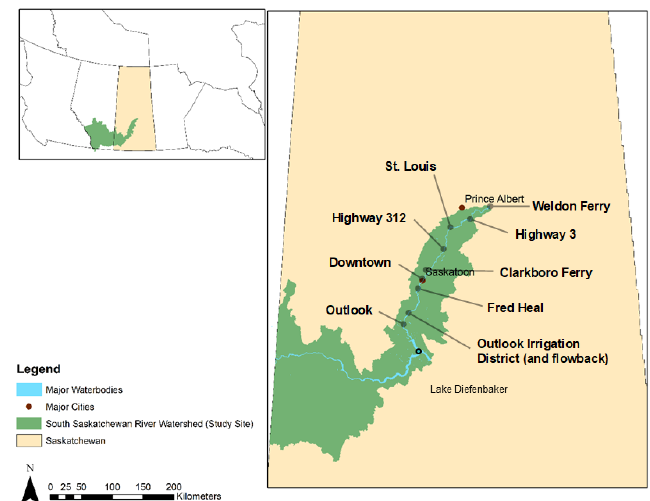
Figure 1. Sampling locations in the South Saskatchewan River Basin, Saskatchewan [ 27 ] . The Red Deer, Bow, and Oldman rivers meet at the confluence of the South Saskatch- ewan River, which is fed by the glaciers of the Rocky Mountains. From its source, the South Saskatchewan River flows for another 1392 kilometres. The SSR has an average dis- charge of 280 m 3 /s at the Saskatchewan River Forks. It covers a watershed of approxi- mately 146,100 km 2 , of which 1800 km 2 are in Montana, United States, and 144,300 km 2 are in Alberta and Saskatchewan [ 29 ] . Agriculture accounts for two-thirds of the land cover [ 30 ] . 2.2. Modelling Approach The change of heavy metals in the South Saskatchewan River system was studied using the Water Quality Analysis Simulation Program 7.52 (WASP) coupled with HEC- RAS. The WASP model could be used to simulate many different aquatic systems. The application could simulate hazardous water contamination using the concepts of mass, momentum, and the conservation of energy. The hydrodynamics of the model domain was simulated using the hydraulic model HEC-RAS 6.3. Since HEC-RAS was developed by the U.S. Army Corp of Engineers (USACE), all users and organizations have access to a free version of the model. HEC-RAS is available to everyone and does not require a license, making it a key benefit of utilizing it as a modelling tool. HEC-RAS can model flow, sediment transport, water quality in one-dimensional (1D) steady and unsteady flow, and two-dimensional (2D) unsteady flow of rivers. The model uses geometric data representation and geometric and hydraulic computer algorithms for a network of river channels. The HEC-RAS program can simulate an input flood using either a (1D) unsteady flow model or a (2D) unsteady flow model following these parameters. Flow data were acquired from available flow data from the Water Survey of Canada (WSC) station at Lake Diefenbaker, which has an operational gauge (records available